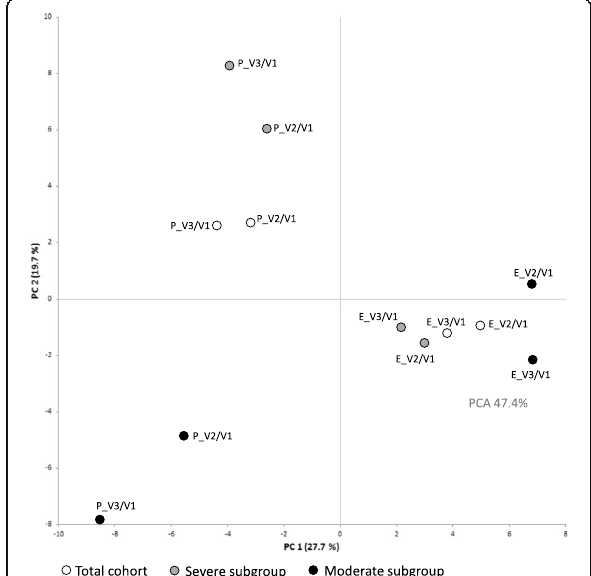
Fig. 7 Principal component analysis (47.4%) of the relative fold-changes calculated for all taxonomic groups (family and genus levels). Each dot represents a treated group (either EpiCor or placebo) for all three co- horts (total cohort, severe and moderate). The first component (PC1) accounts for nearly 28% of the variance, and the second component (PC2) for nearly 20%. legend: E, Epicor; P, placebo; V, visit